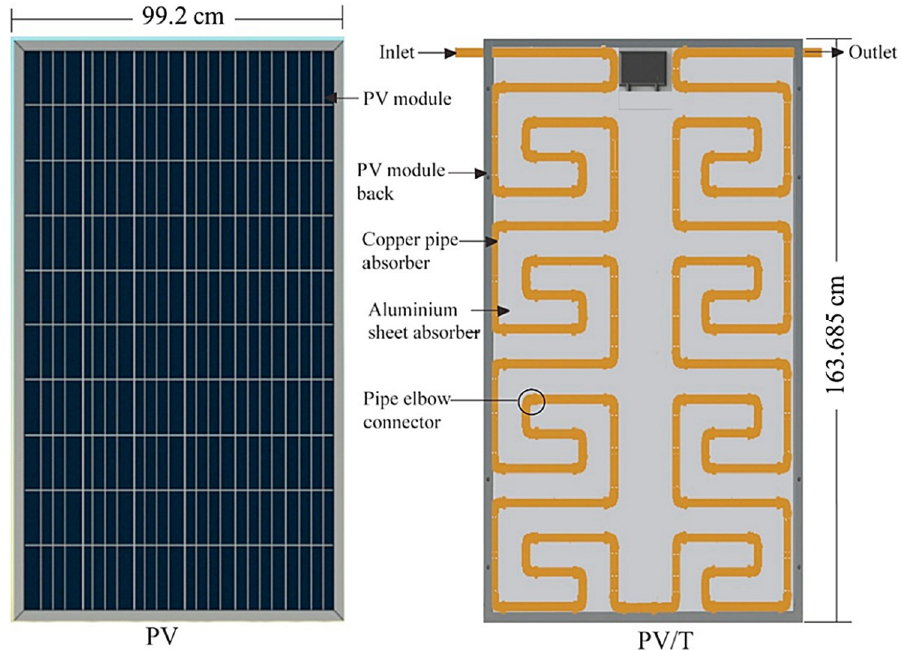
Figure 6. PVT thermal absorber with two sides serpentine configuration. Reprinted with permission from Ref. [75]. 2019. Hossain et al.